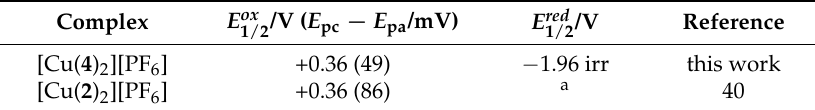
Figure 3. Solution absorption spectra of ( a ) [Cu( 4 ) 2 ][PF 6 ] (CH 2 Cl 2 , 1 × 10 − 5 mol dm − 3 ) and ( b ) a comparison of CH 2 Cl 2 solutions of [Cu( 4 ) 2 ][PF 6 ] freshly made and after standing for 10 days. Table 1. Cyclic voltammetric data for [Cu( 4 ) 2 ][PF 6 ] compared to [Cu( 2 ) 2 ][PF 6 ] with respect to Fc/Fc + ; CH 2 Cl 2 solutions with [ n Bu 4 N][PF 6 ] as supporting electrolyte and scan rate of 0.1 V s − 1 . (irr = irreversible).